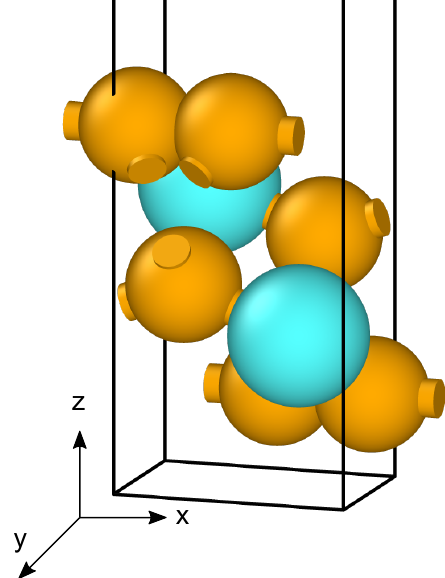
Figure 1. Representation of a TiS 3 unit cell with atoms painted in blue for titanium and in orange for